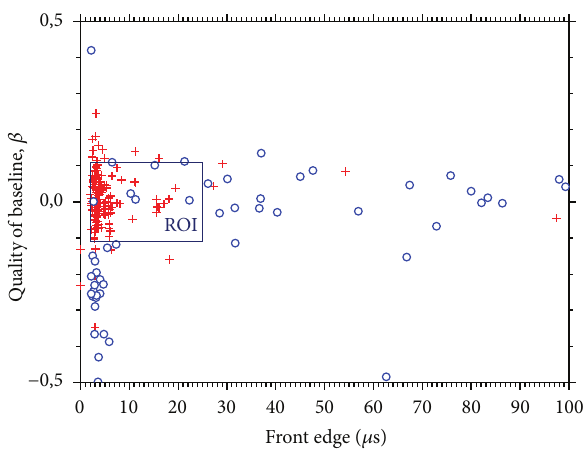
Figure 6: The distribution of the events for UV lamp.